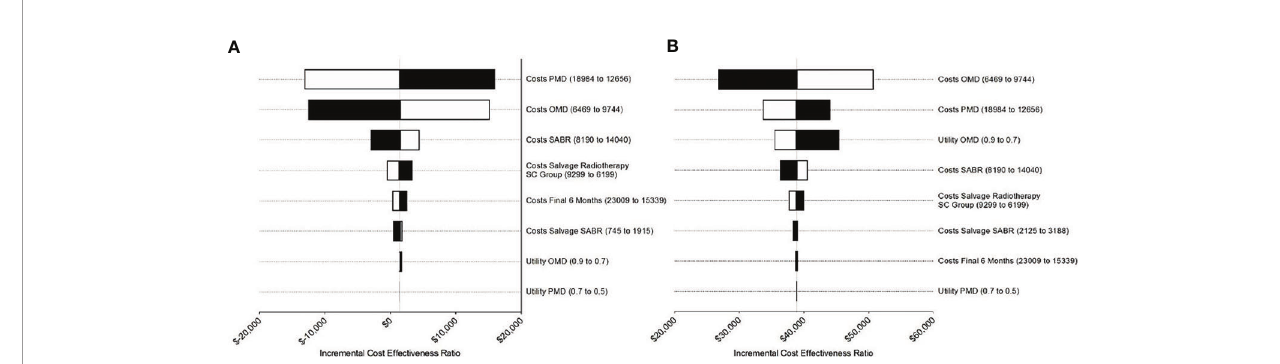
FIGURE 2 | Tornado diagrams for the sensitivity analysis during (A) the trial duration and (B) long-term simulation extrapolated based on SEER survival data. (A) Costs for PMD and OMD demonstrated the strongest impact on ICER during trial duration. (B) For long-term analysis costs for PMD in fl uenced ICER the most followed by costs for PMD and utility for OMD.